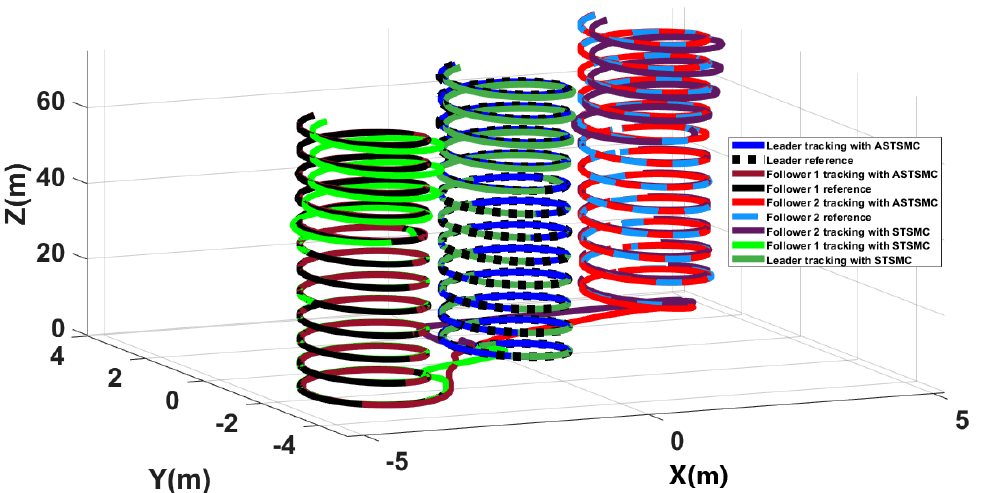
Figure 4. XYZ trajectory tracking comparison under wind disturbance.